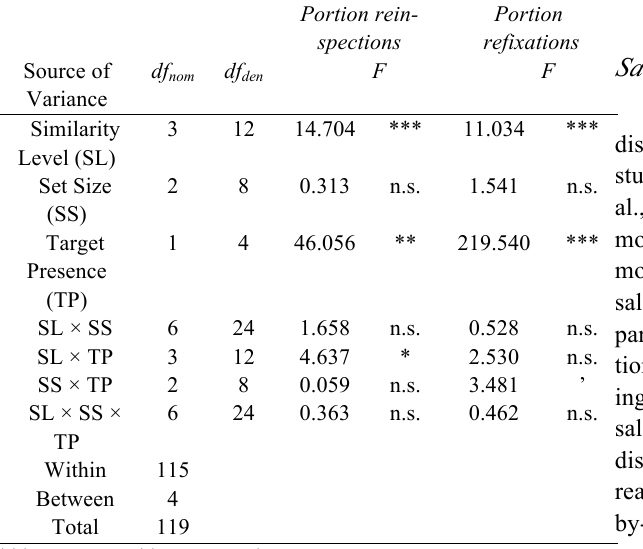
Three-way repeated measures analysis of variance for portion reinspections and portion